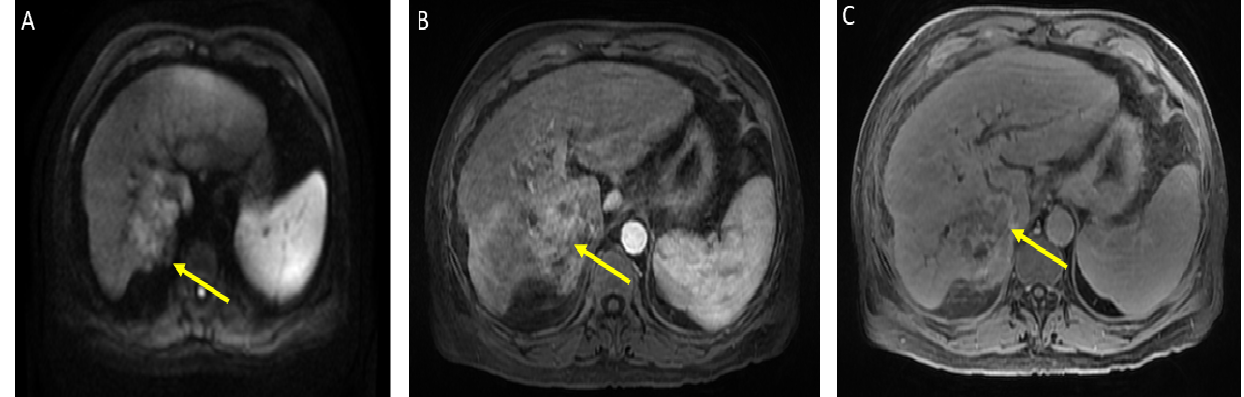
Figure 1. Magnetic resonance imaging of the abdomen. Limited by motion. Cirrhosis and splenomegaly were noted. Infiltrative segment 7 mass measures 6.5 × 4 cm. ( A ) Diffusion-weighted imaging (DWI) shows diffusion restriction of mass; ( B ) T1 with contrast shows vague arterial phase enhancement; ( C ) T1 post-contrast delayed phase imaging shows washout (captured at the diagnosis visit, and before the atezolizumab plus bevacizumab started).